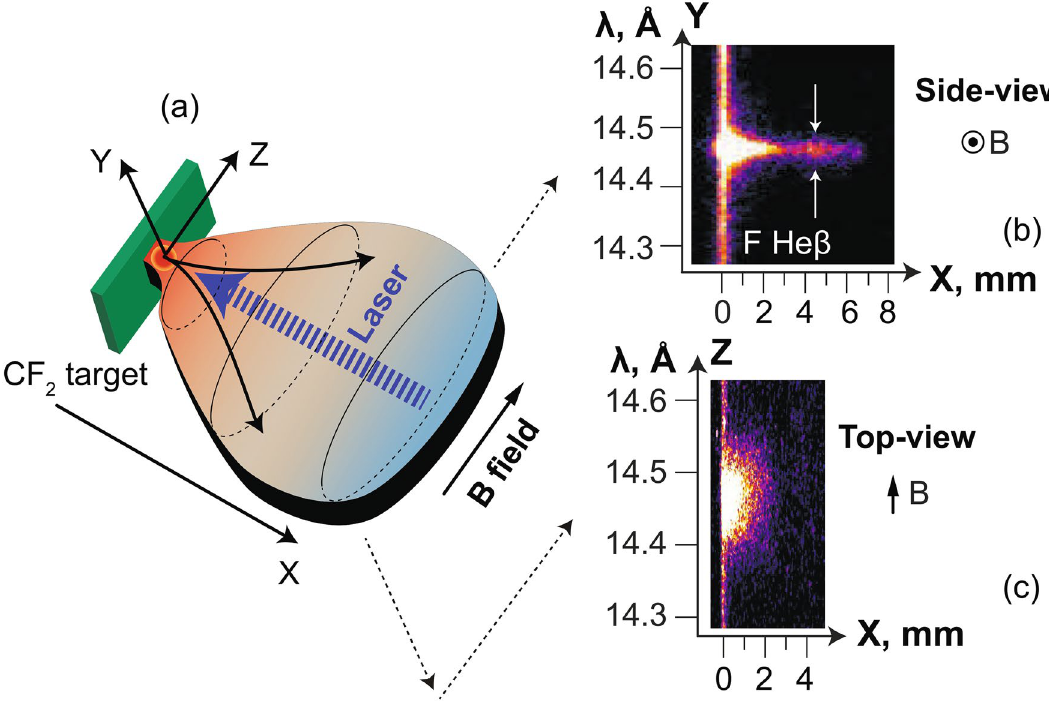
Figure 1. ( a ) Setup of the experiment and global plasma morphology resulting from the plasma-magnetic field interaction. A solid (Polytetrafluoroethylene (PTFE), CF 2 ) target, mimicking an ICF hohlraum wall, is immersed in a large-scale, steady, axial and strong (up to 30 T) magnetic field that is aligned with the target 2 1 surface (along the z-axis). A long (0.6 ns FWHM) high-power (40 J, 4 × 10 13 W/cm ) laser pulse at (cid:31) = µm irradiates the wall at normal incidence, inducing plasma heating and expansion. The laser was focused using a 2.2 m focal length lens (f/21) and a random phase plate 25 . ( b,c ) The images on the right represent the X-ray self-emission images of fluorine He β spectral line obtained by viewing the 3D plasma side-on (i.e. in the XY plane) and from the top (i.e. in the XZ plane) where there was an 20 T applied magnetic field. These images are time-integrated and measured simultaneously on the same shot by two focusing spectrometers with spatial resolution (FSSR) deployed in the experiment (see “Methods” section). The images demonstrate that the global morphology of the plasma corresponds to that sketched in the cartoon ( a ), i.e. of a plasma that becomes extended in the XZ plane, while it is compressed in the XY plane. The white arrows in the side-view point to the 4 mm (see increase in emissivity in the spatial region ∼